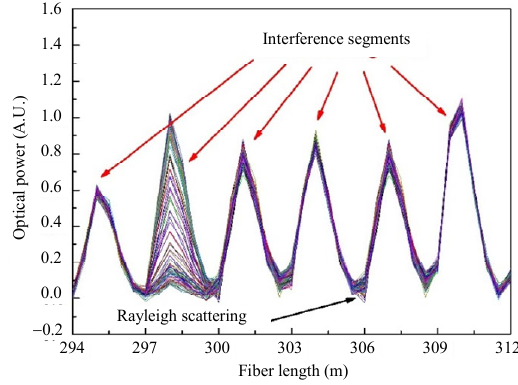
Fig. 9 Parts of superposition of all 100 output optical pulse sequence from PD1 when only PZT1 has a vibration.